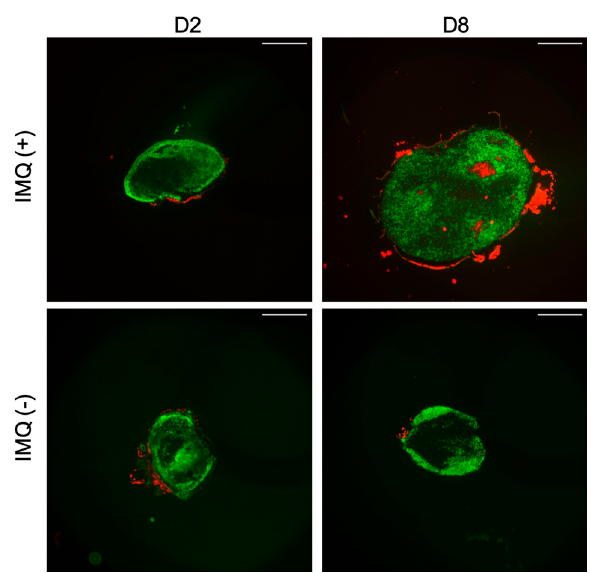
Figure 11. Immunofluorescent staining of germinal centers in mice inguinal lymph nodes. Sections were stained with anti-mouse IgD (BioLegend) to detect B cells follicles (green), and with biotinylated peanut agglutinin (PNA) (Vectors Laboratories) to detect germinal centers (red). Scale bar = 500 μ m.